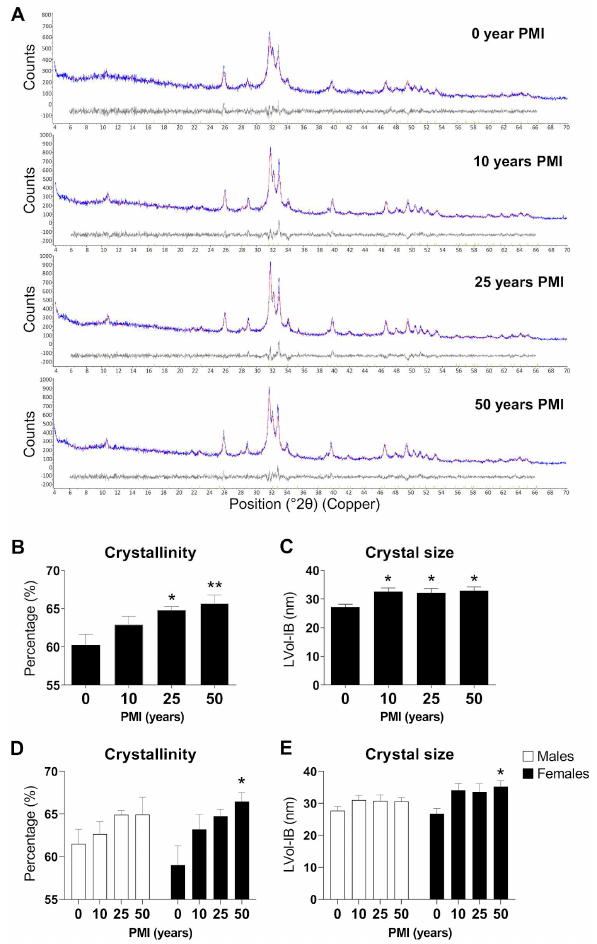
Figure 1. Analysis of crystallographic indices in teeth to determine the postmortem interval. ( A ): Representative XRD spectra for 0, 10, 25 and 50 years of PMI. ( B ): Crystallinity Index for 0, 10, 25 and 50 years of PMI. ( C ): Crystal Size for 0, 10, 25 and 50 years of PMI. ( D ): Crystallinity Index in males versus females for 0, 10, 25 and 50 years of PMI. ( E ): Crystal Size in males versus females for 0, 10, 25 and 50 years of PMI. Histograms represent means ± SD ( n = 10). */** p < 0.05/0.01 versus control